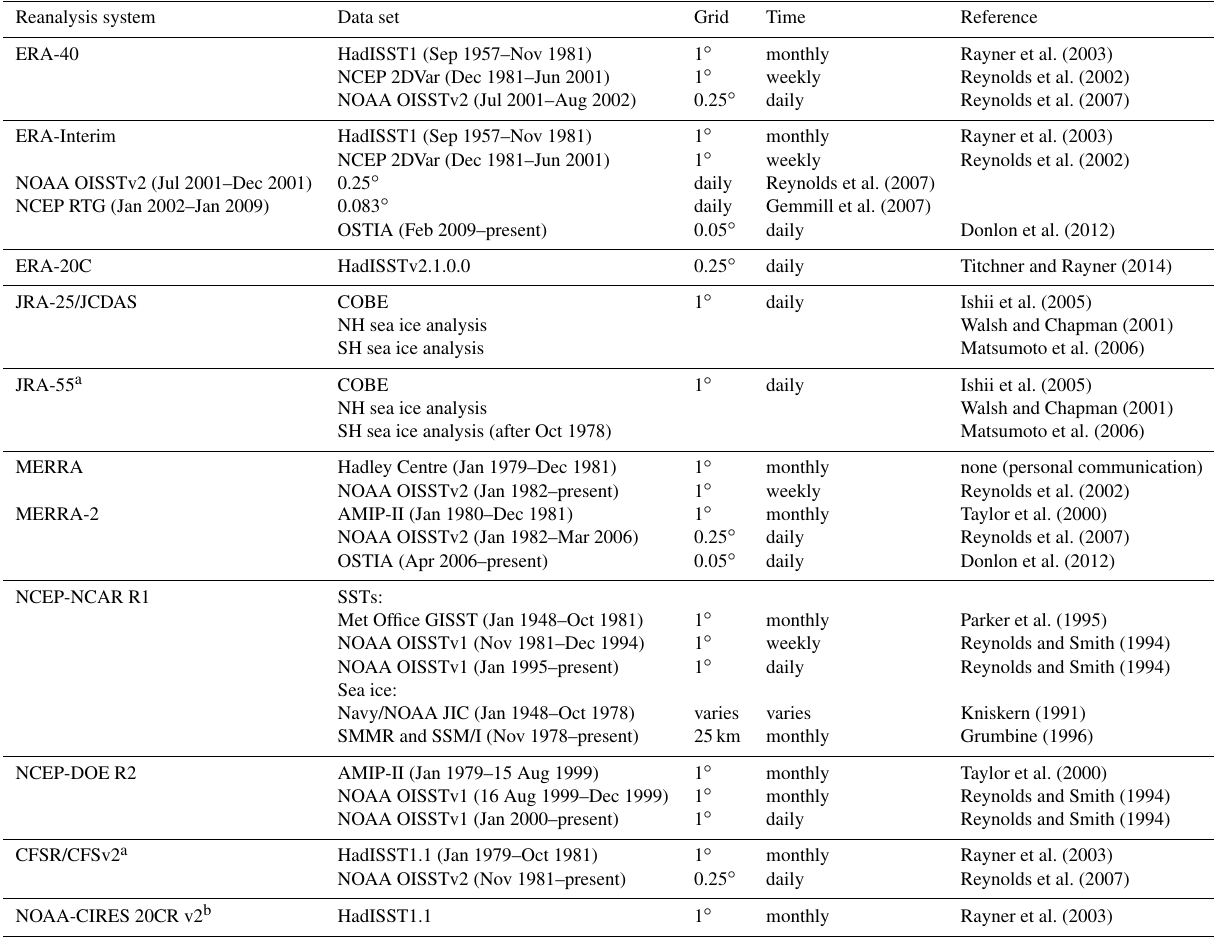
Table 4. Sources of SST and sea ice lower boundary conditions used in